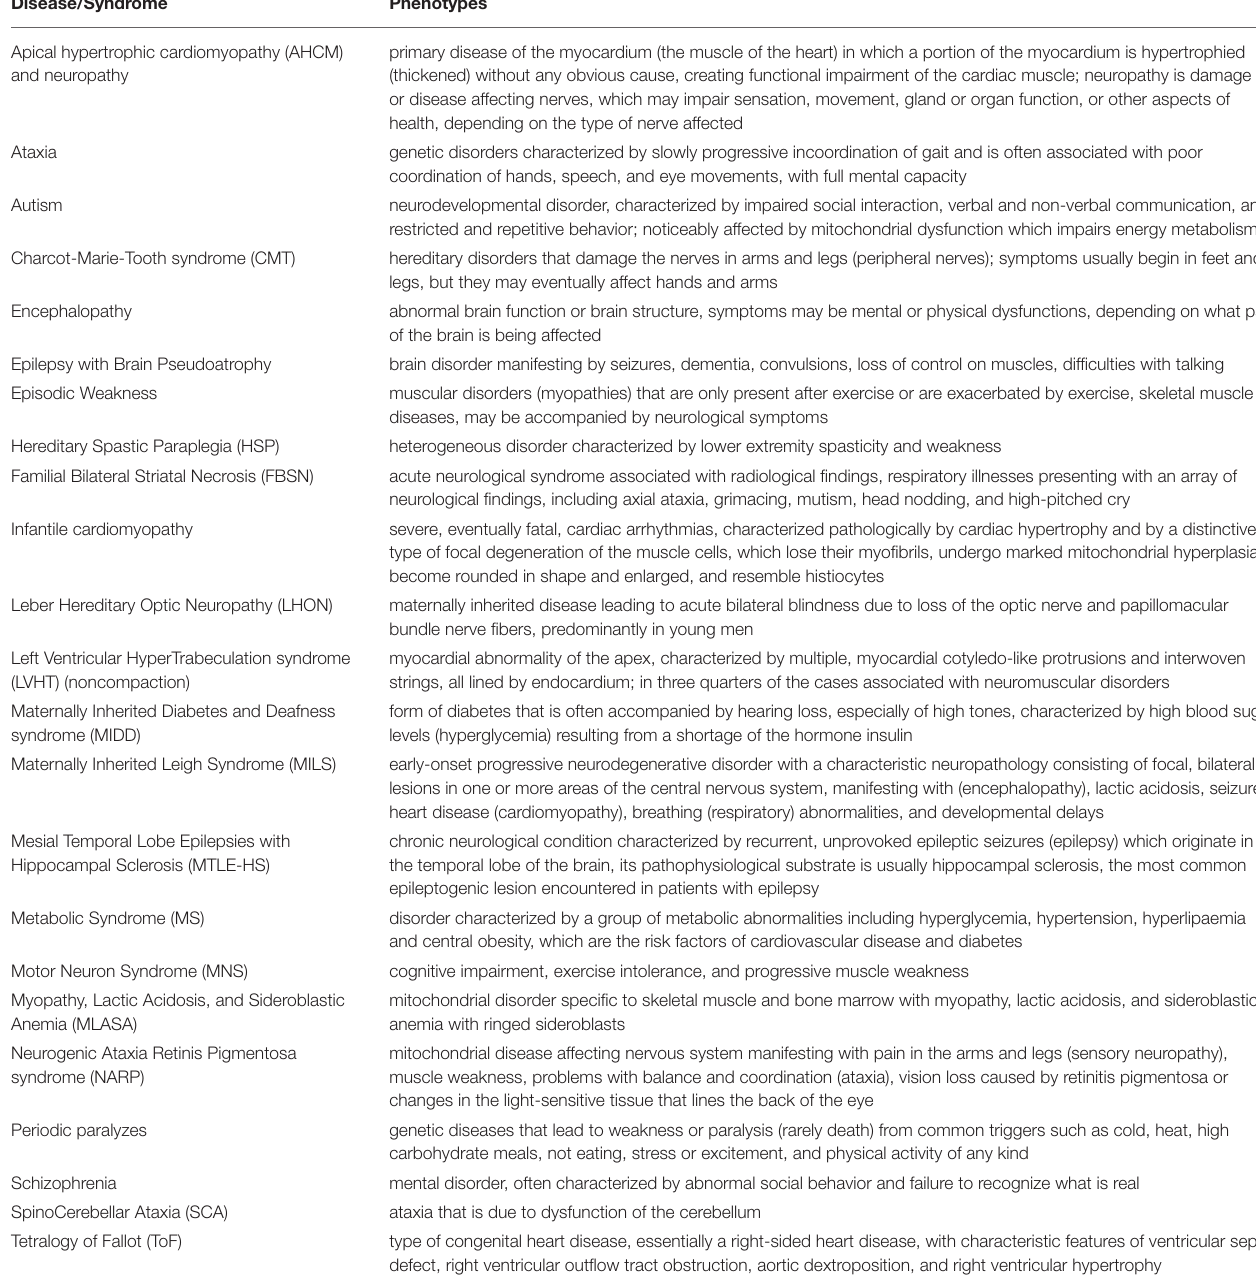
TABLE 1 | Diseases and syndromes caused by mutations in ATP8 and ATP6.